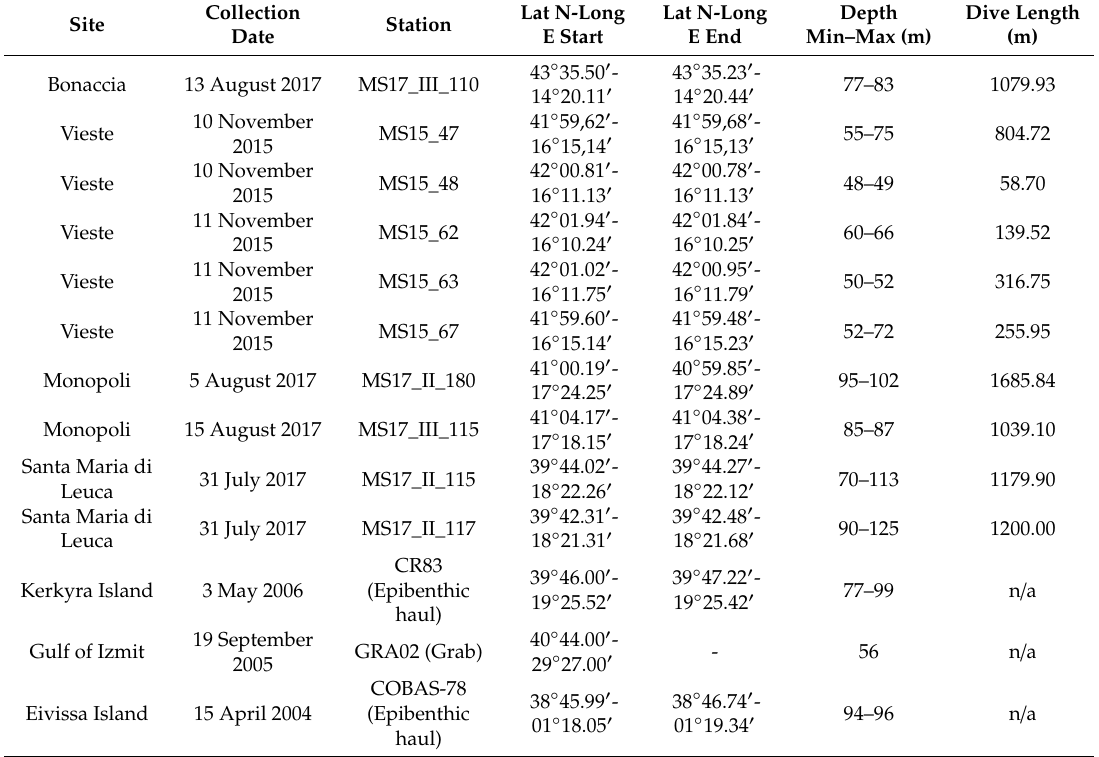
Table 1. Site locations